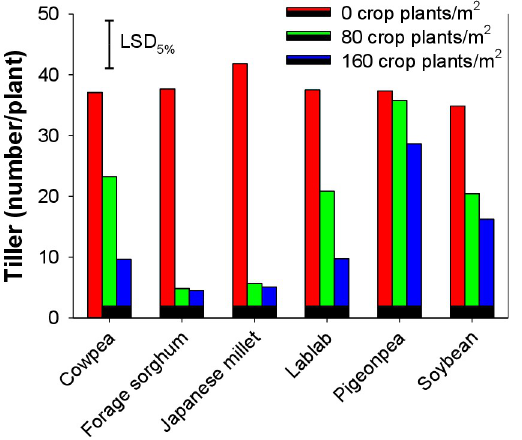
Fig 3. Tiller number of Echinochloa colona when it was grown alone or in interference with 80 and 160 plants m -2 of various cover crops.